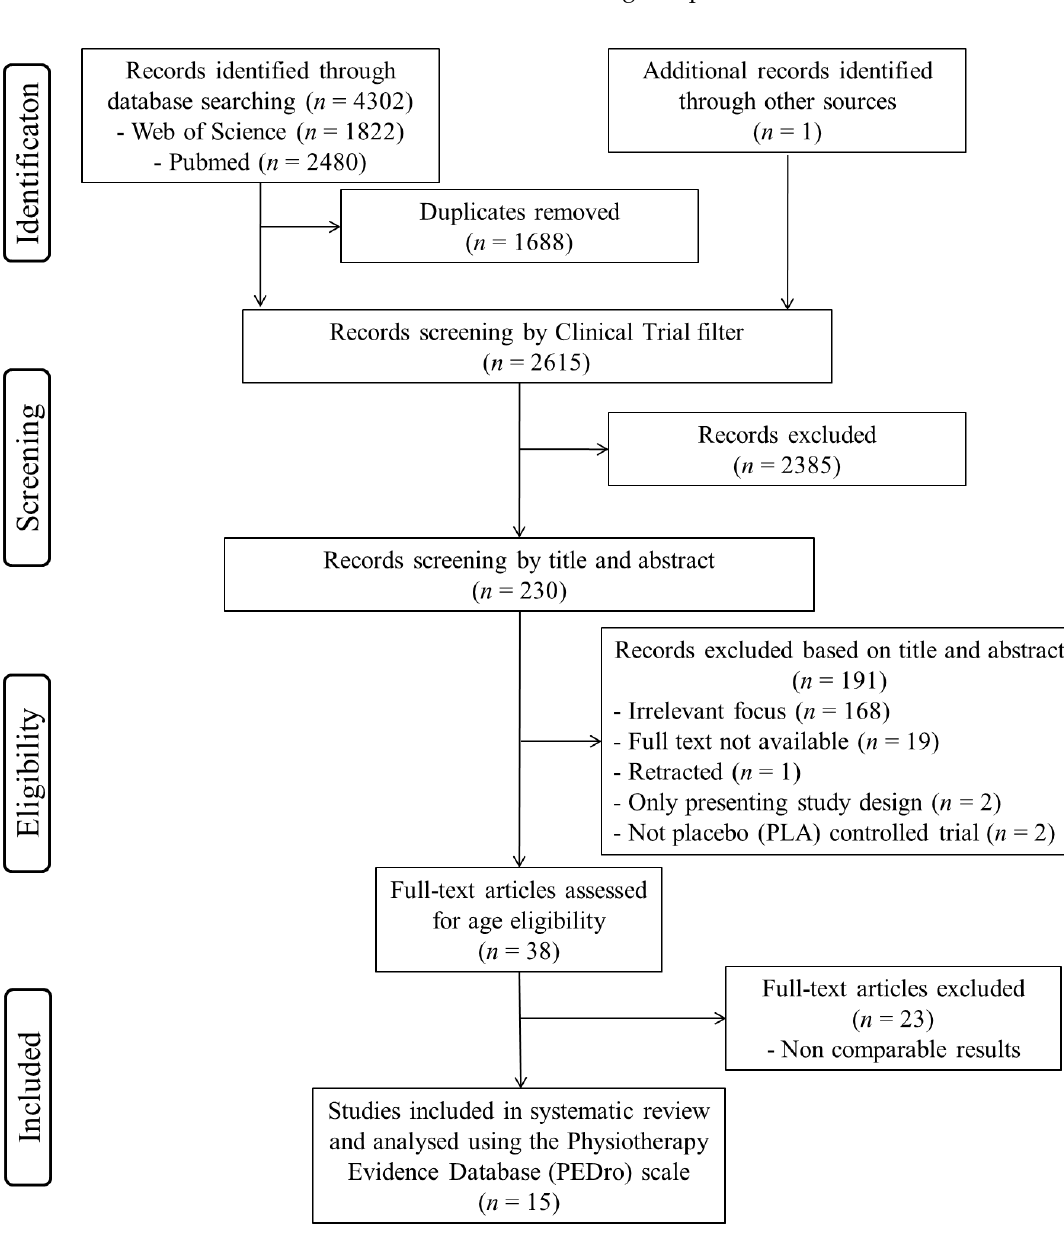
Figure 1. Flow diagram of the literature selection process.